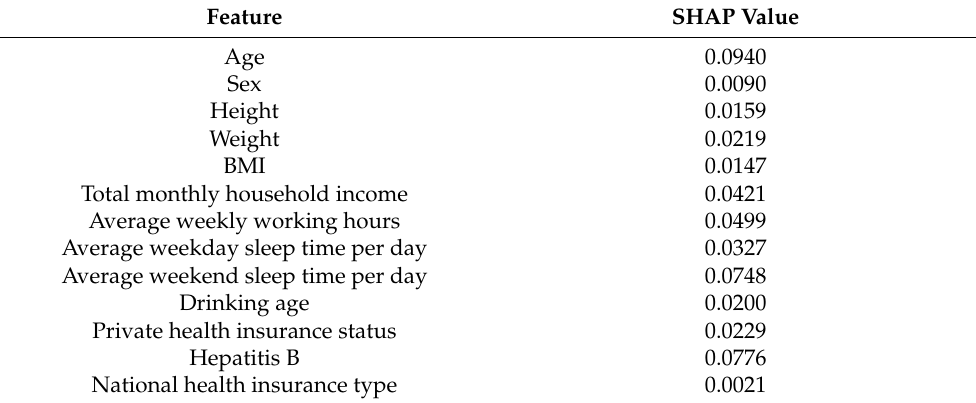
Table 11. SHAP values of the risk association model for liver cancer.